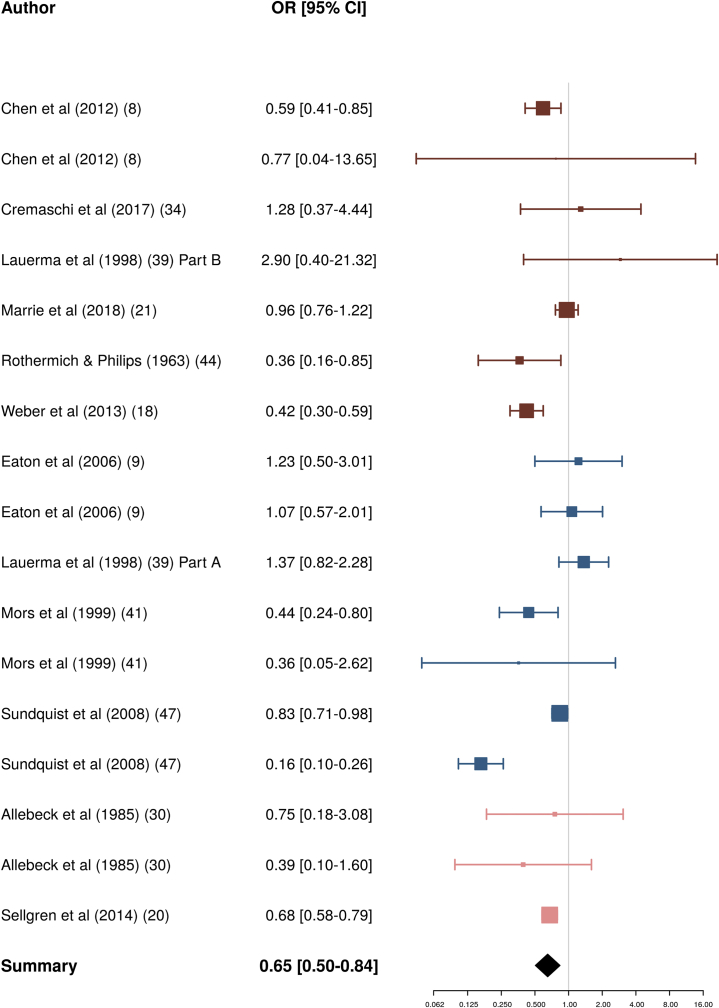
Results of meta-analysis for rheumatoid arthritis and psychosis. All studies examine schizophrenia with the following exceptions: Allebeck et al. (1985; second row) (30), nonschizophrenia psychosis; Sundquist et al. (2008; first row) (47), nonschizophrenia psychosis; Rothermich and Philips (1963) (44), broadly defined psychosis. Specific rheumatoid arthritis subtypes are as follows: Chen et al. (2012; second row) (8), juvenile-onset; Eaton et al. (2006; second row) (9), seropositive; Mors et al. (1999; second row) (41), juvenile-onset. Marker and line colors indicate study design: type A (red), type B (blue), type C (pink). CI, confidence interval; OR, odds ratio.